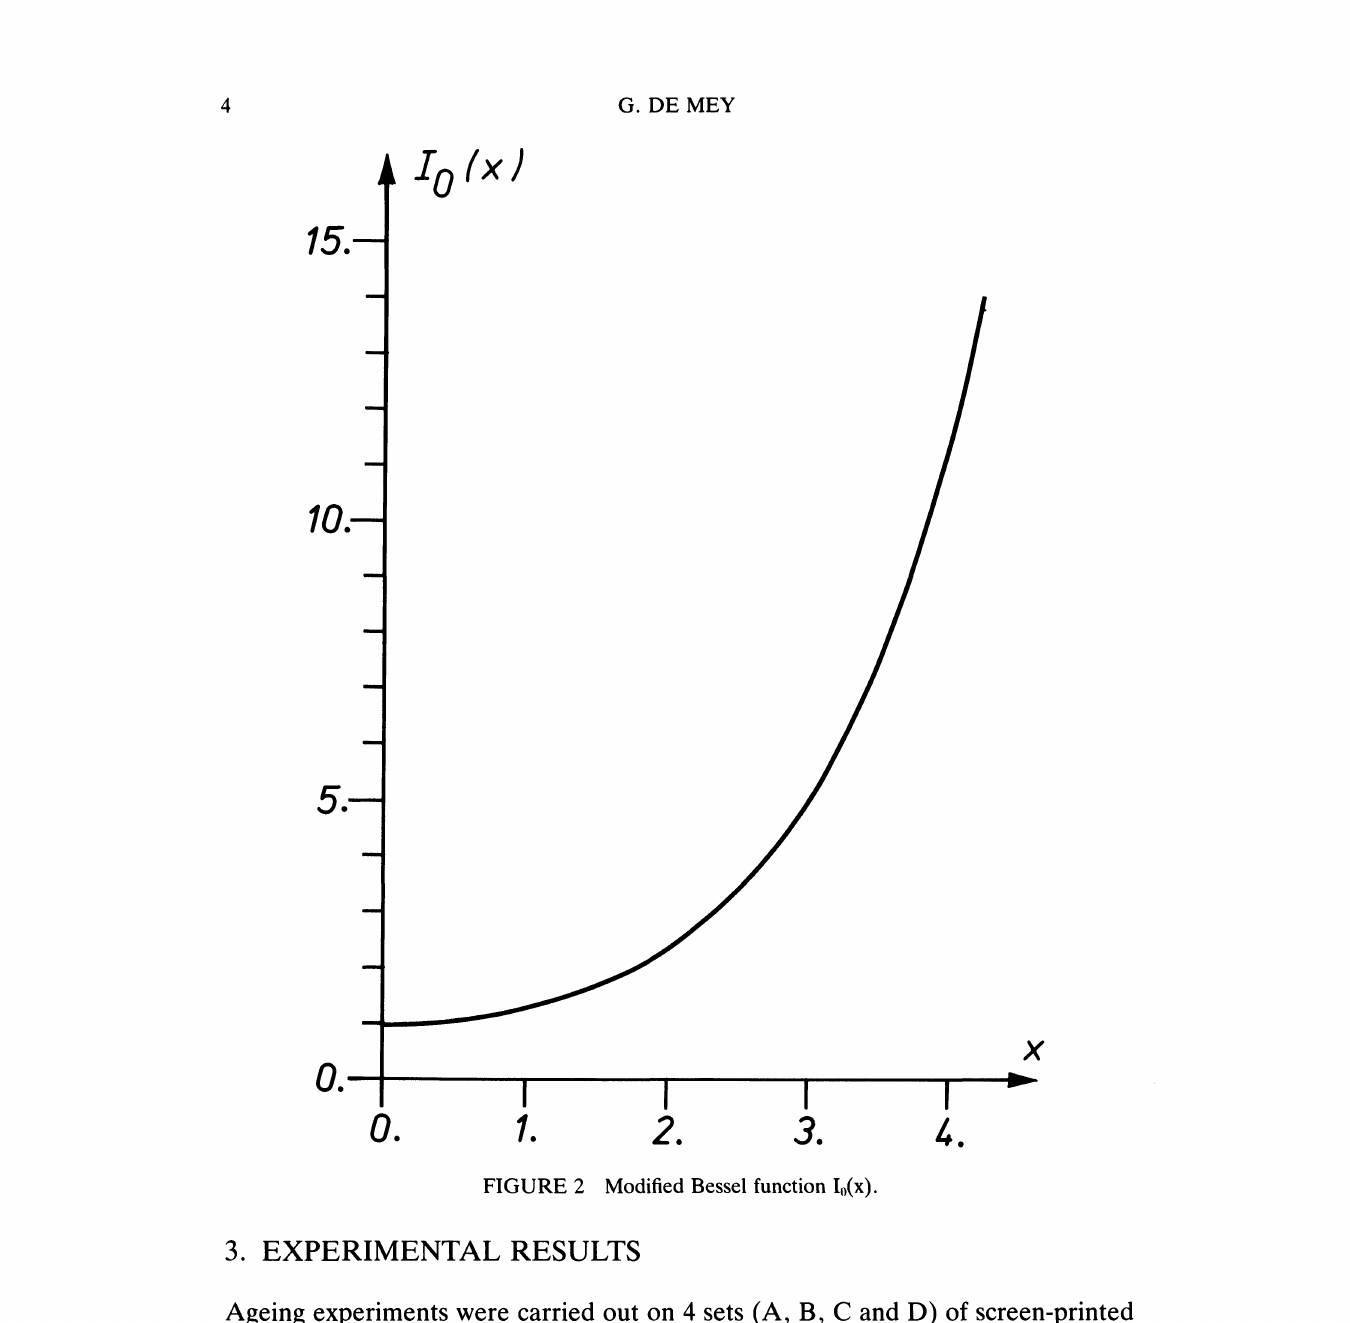
FIGURE 2 Modified Bessel function